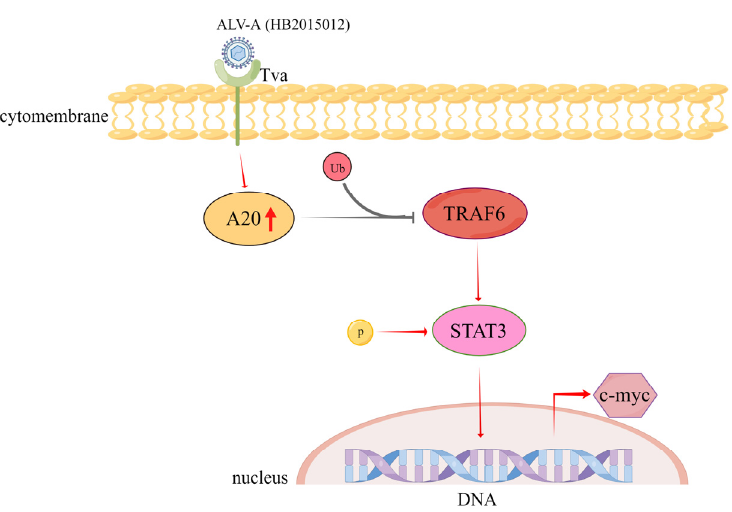
Figure 7. ALV-A (rHB2015012) promotes tumorigenesis signaling through A20. ALV-A (rHB2015012) infection increases the expression level of A20. It inhibits TRAF6 ubiquitination, leading to its upregulation, and TRAF6 upregulation promotes STAT3 phosphorylation, which in turn promotes the proto-oncogene c-myc expression, resulting in tumorigenesis.